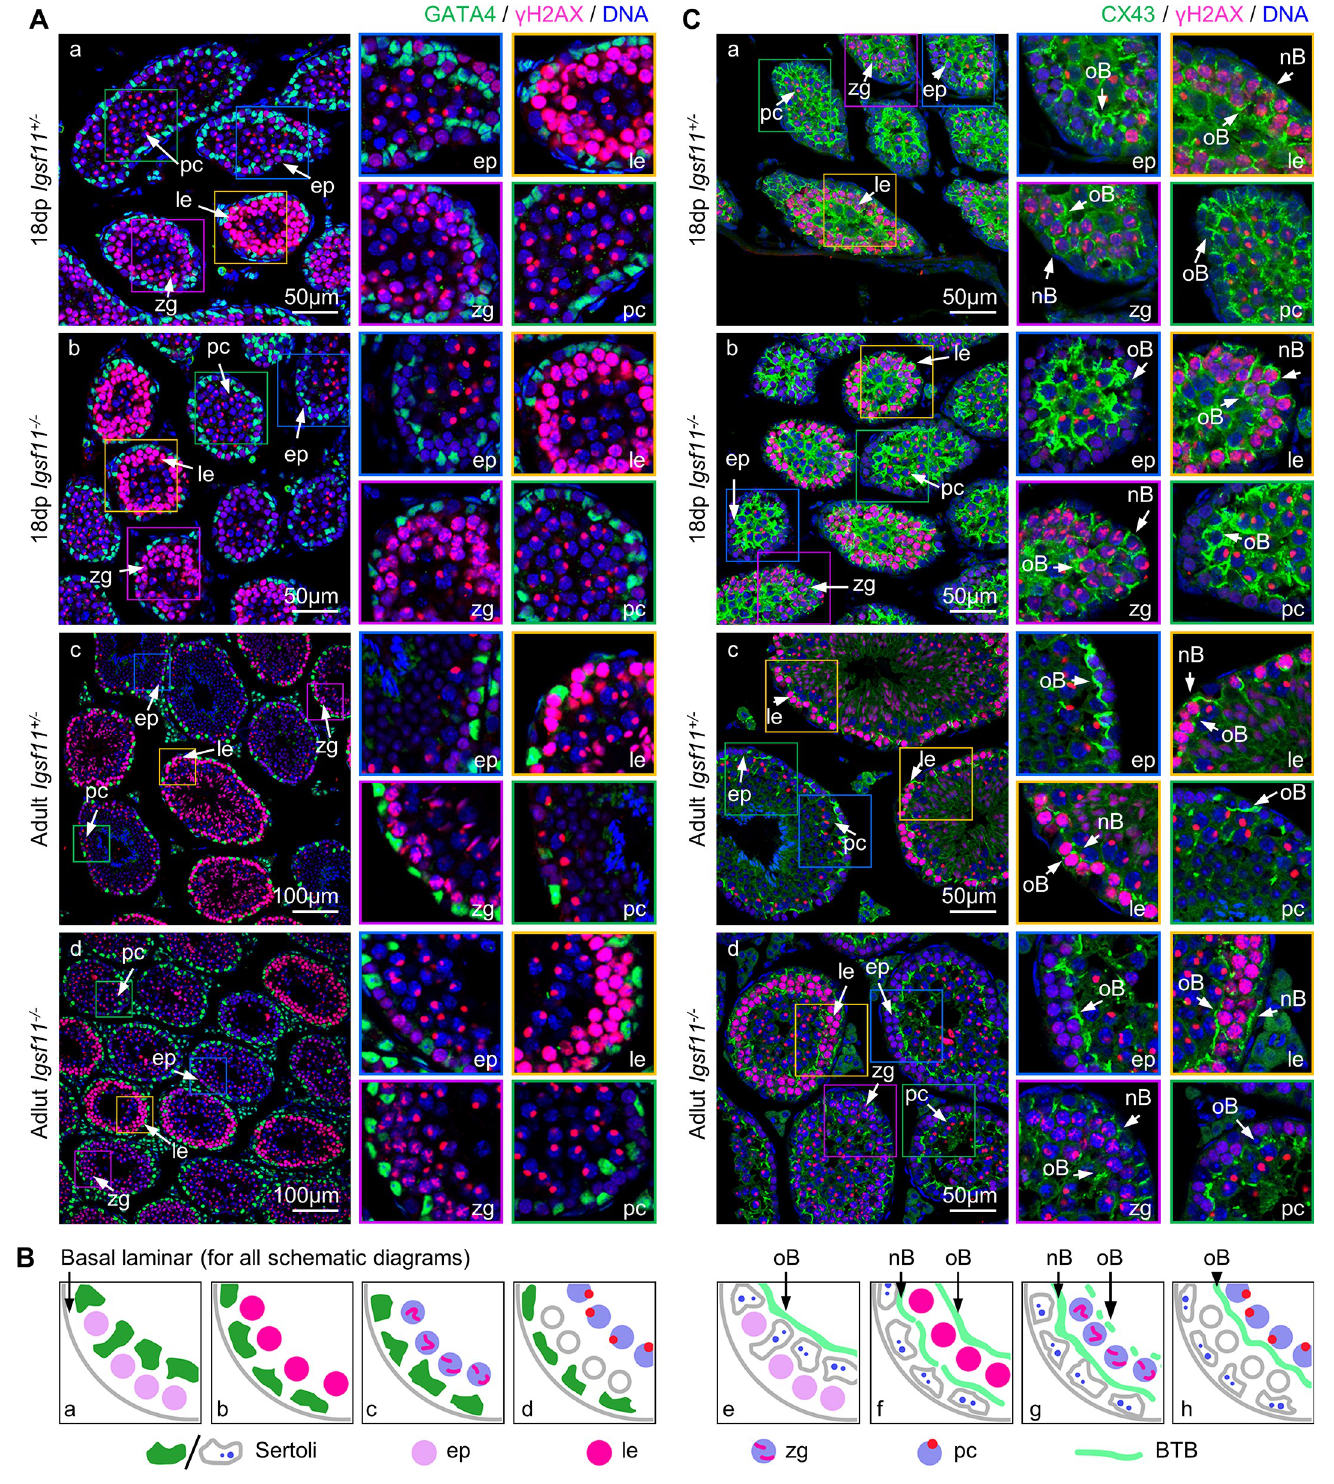
Fig 4. Localizations of Sertoli cells and spermatocytes in seminiferous tubules are not affected in the absence of Igsf11 . (A) Comparison of the localization patterns of Sertoli cells and spermatocytes in the control ( Igsf11 +/- ) and mutant ( Igsf11 -/- ) mice using GATA4 and γ H2AX as markers. (B) Schematic diagrams of the staining results in (A) and (C). (C) Comparison of spermatocytes migration and BTB reconstruction in control ( Igsf11 +/- ) and mutant ( Igsf11 -/- ) mice using CX43 and γ H2AX as markers. Note that not all CX43 signals are restricted to BTB in the 18 dpp seminiferous tubules. Abbreviations: ep, early-leptotene; le, leptotene; zg, zygotene; pc, pachytene; nB, new BTB; oB, old BTB.